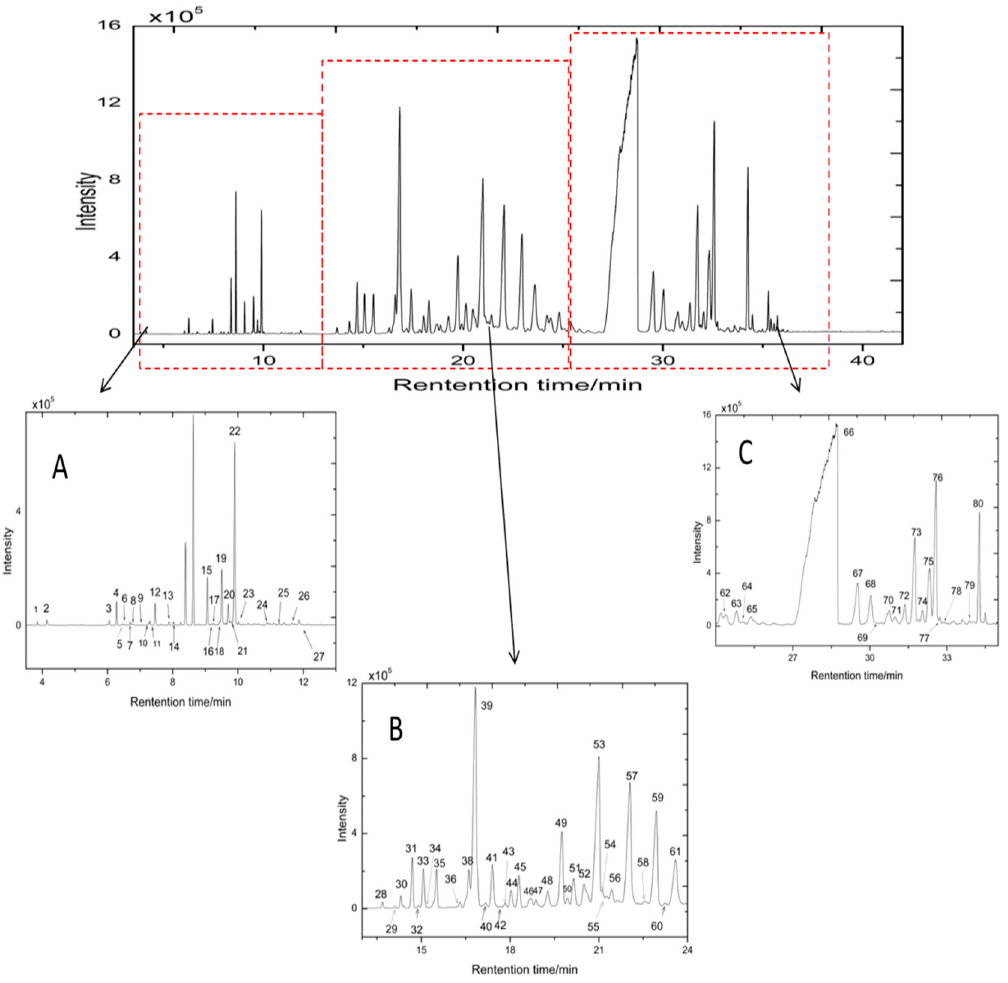
Figure 1. Representative gas chromatography–mass spectrometry (GC-MS) fingerprint of acorus tatarinowii rhizoma (ATR): ( A ) total ion chromatogram (TIC) of ATR at 3–13 min; ( B )TIC of ATR at 13–24 min; ( C ) TIC of ATR at 24–35 min. Eighty volatile components were detected by GC-MS.